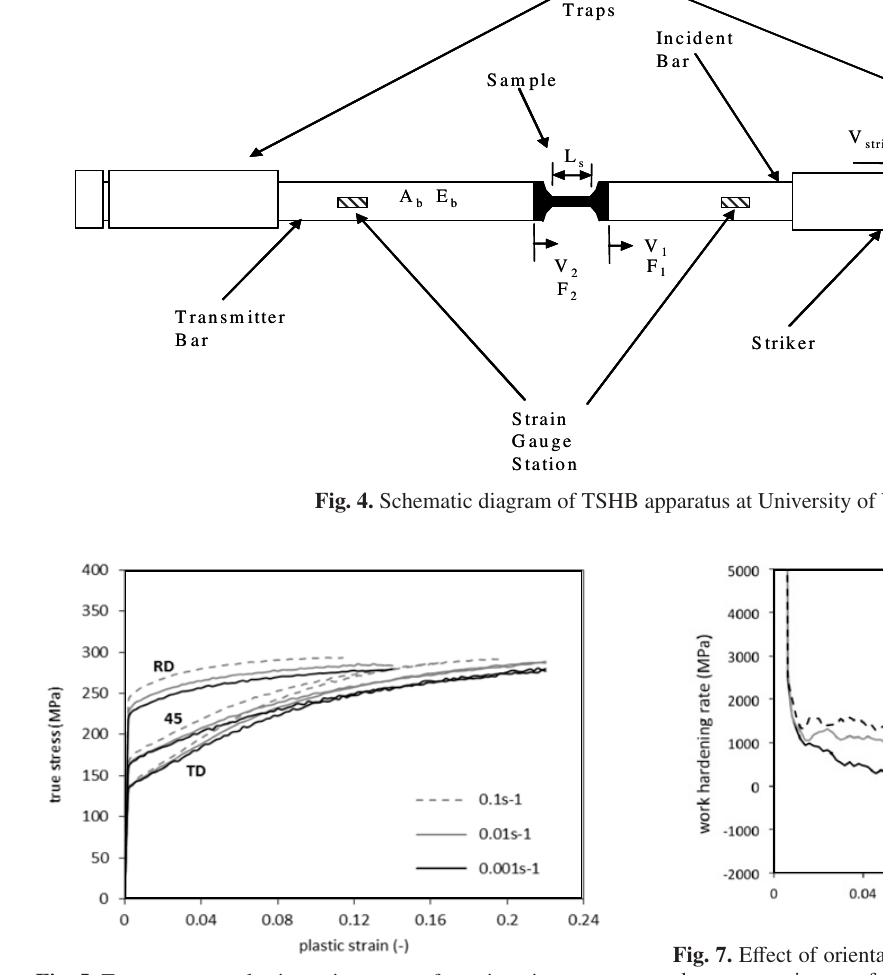
Fig. 5. True stress vs. plastic strain curves of quasi-static tests at 0 . 001 s − 1 , 0 . 01 s − 1 and 0 . 1s − 1 in the RD, TD and 45 ◦ direction.